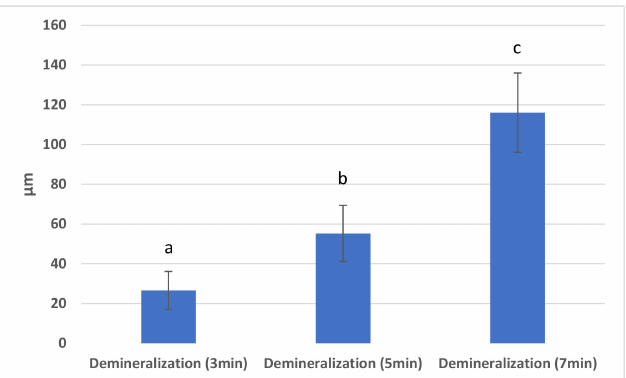
Figure 4. Demineralisation cycle. Different letters indicate statistically significant differences p ≤ 0.05 (Duncan’s test).